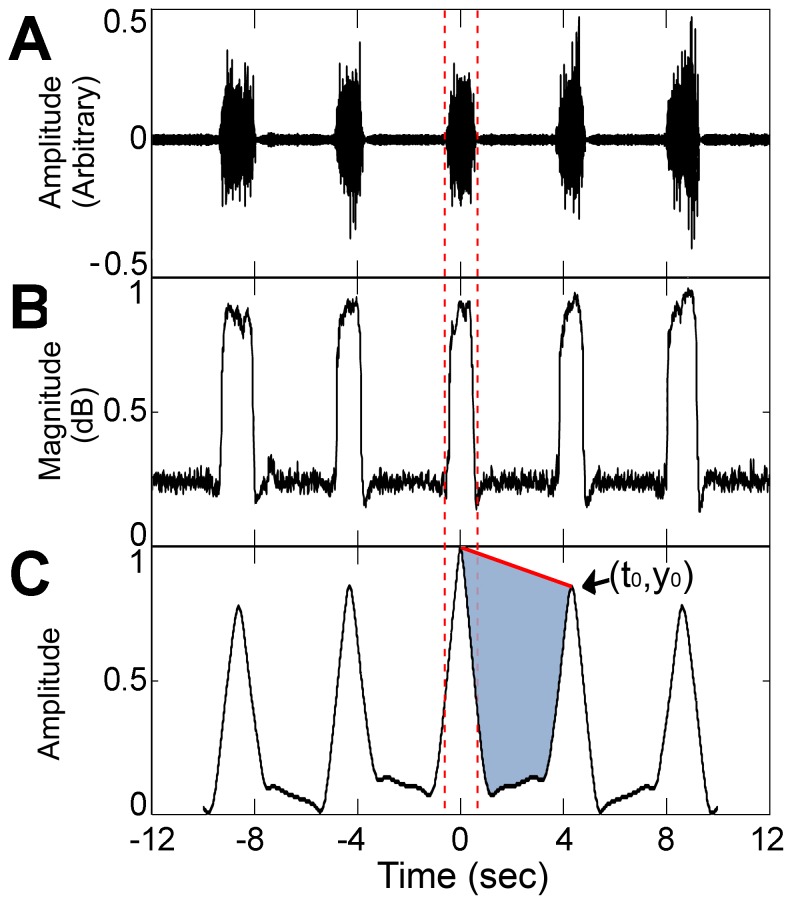
Demonstration of the major periodicity features.A) Audio signal containing snore pattern. B) The energy signal – achieved by a logistic transformation over the standard energy signal to emphasize the rhythm pattern. C) Smoothed autocorrelation R(τ) of the segment. In this example, the rhythm period was equal to t0 = 4.1 seconds with intensity of y0 = 0.8. Note that the tested event is aligned at t = 0 and t = 12 seconds for each side being tested. The shaded area in C represents the period's intensity feature. A more periodic energy pattern will result in a greater area and, hence, a greater period intensity value. The features were calculated for each tested event (between dashed vertical lines) by exploring the event's surroundings.